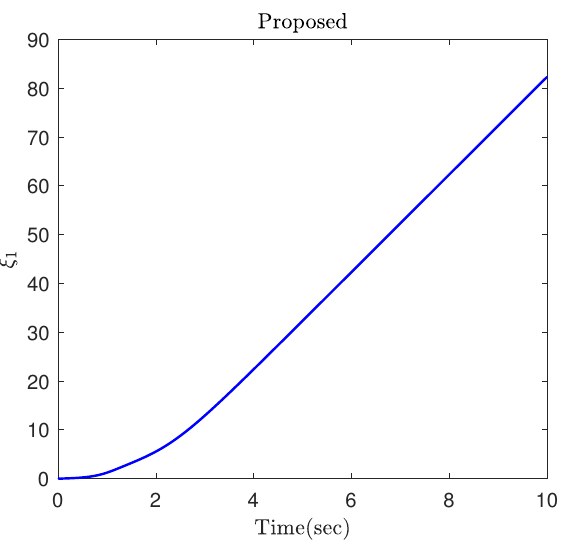
Figure 15. The parameter ξ 1 in Part